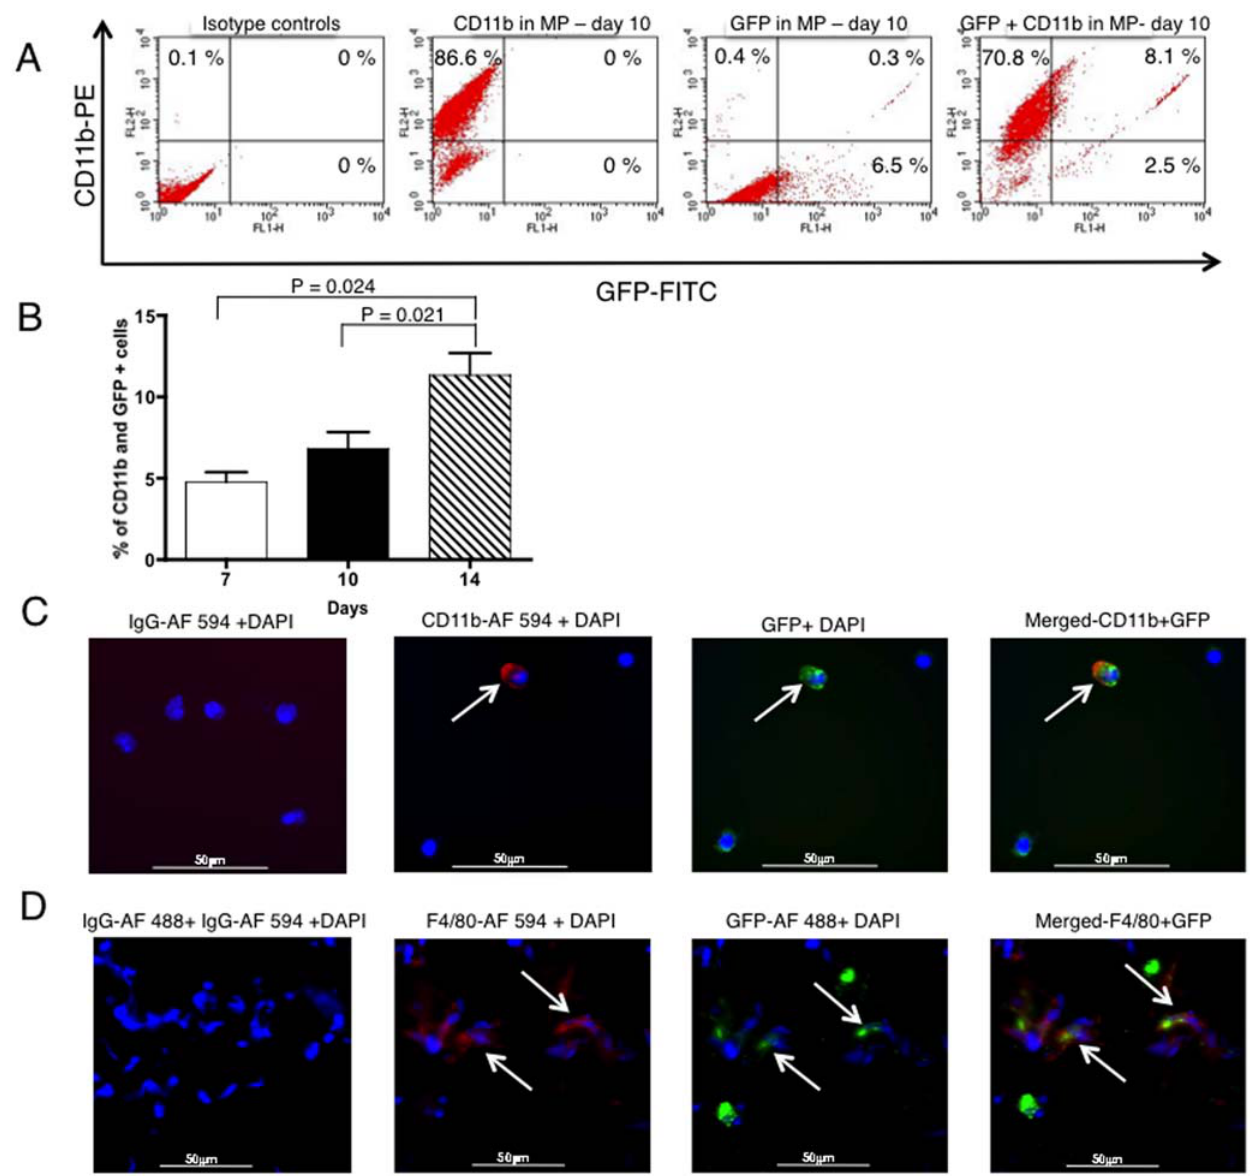
Figure 5. GFP uptake by local infiltrating Matrigel TM plaque macrophages from GFP-labeled hBMSCs. Representative flow cytometry dot plots showing 8.1% of CD11b-PE and GFP-FITC positive macrophages in MPs harvested ten days post-implantation (A), Bar graph showing the mean percentage of CD11b + GFP + cells in all MPs collected 7, 10 and 14 days after implantation of MPs containing 2 6 10 6 xenogenic hBMSCs (B) Note gradual increase in the uptake of GFP by macrophages over time with statistically significant increase in the GFP uptake between day 7 and day 14 (p=0.024) and day 10 and day 14 (p=0.021). Immunofluorescent detection of GFP and CD11b with anti-mouse CD11b-Alexa Fluor 594 on cytospins of cells recovered from MPs ten days post-implantation (magnification 40X), (C). On the merged image, note cell only positive for GFP and a macrophage positive for GFP and CD11b-Alexa Fluor 594. Immunofluorescent detection of GFP and F4/80 with anti-GFP-Alexa 488 and anti-mouse F4/80-Alexa Fluor 594 on frozen sections of MPs ten days post-implantation (magnification 40X), (D). Cells positive for GFP and macrophage marker, F4/80, are indicated by arrows. Data are presented as a mean 6 1 SD from 12–18 plaques.